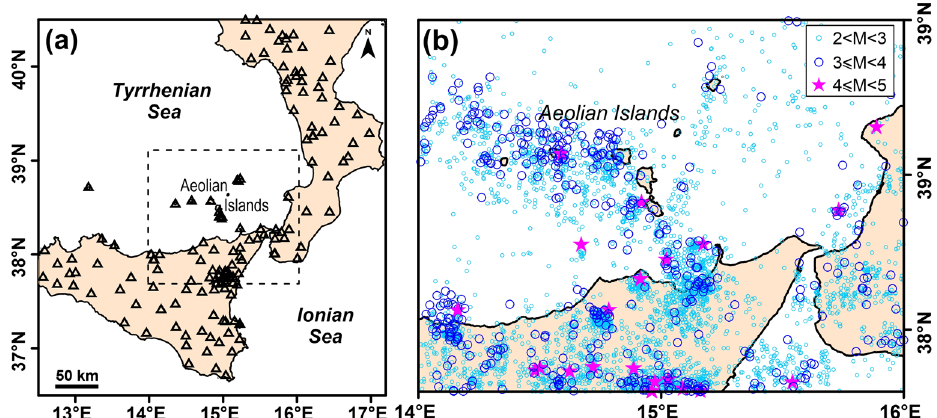
Figure 5. ( a ) Map of the seismic stations used in the present study (triangles). The dashed rectangular box indicates the tomographic inversion area. ( b ) Epicentral distribution of the starting inversion earthquake dataset. Events are reported with different symbols according to their magnitude (see